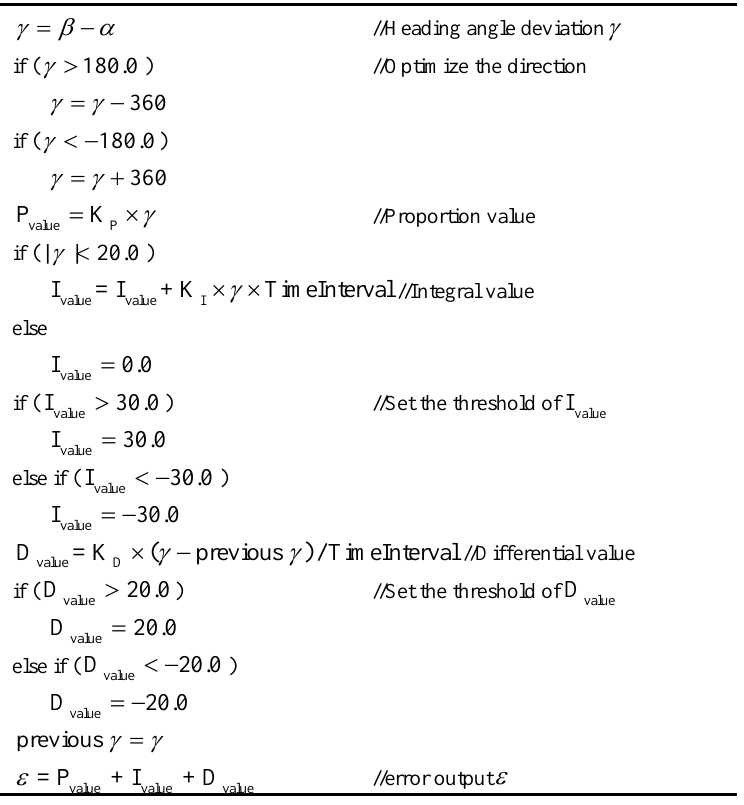
Table 1. PID control